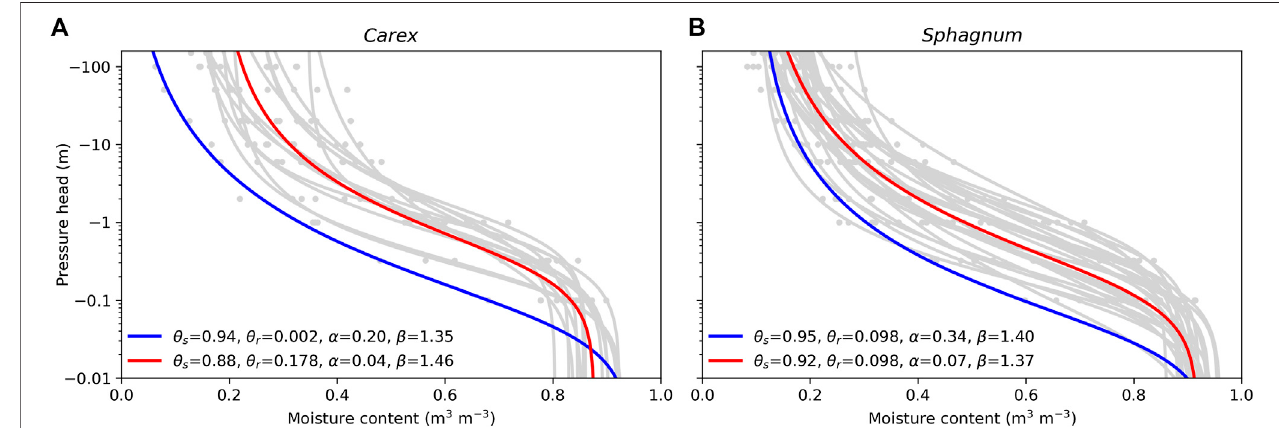
FIGURE3| Waterretentionof Carex (A) and Sphagnum (B) samplespublishedbyPäivänen(1973):waterretentioncurvesforindividualsamplesingray,forwhole data in red, and for sample with poorest water retention capacity in blue. θ s (cid:1) soil porosity; θ r (cid:1) residual water content; α , β (cid:1) van Genuchten water retention curve parameters.